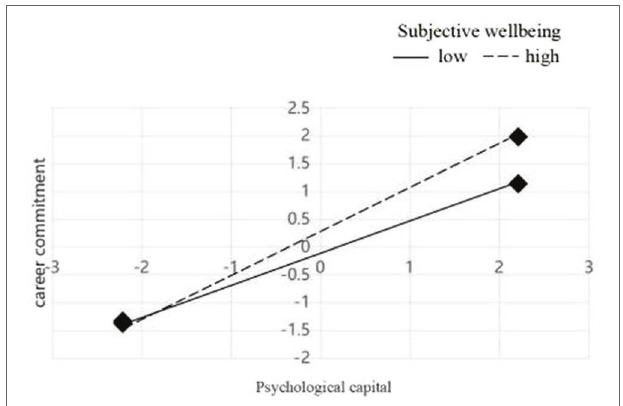
FIGURE 5 | PsyCap interacting with SWB and predicting career commitment ( N =